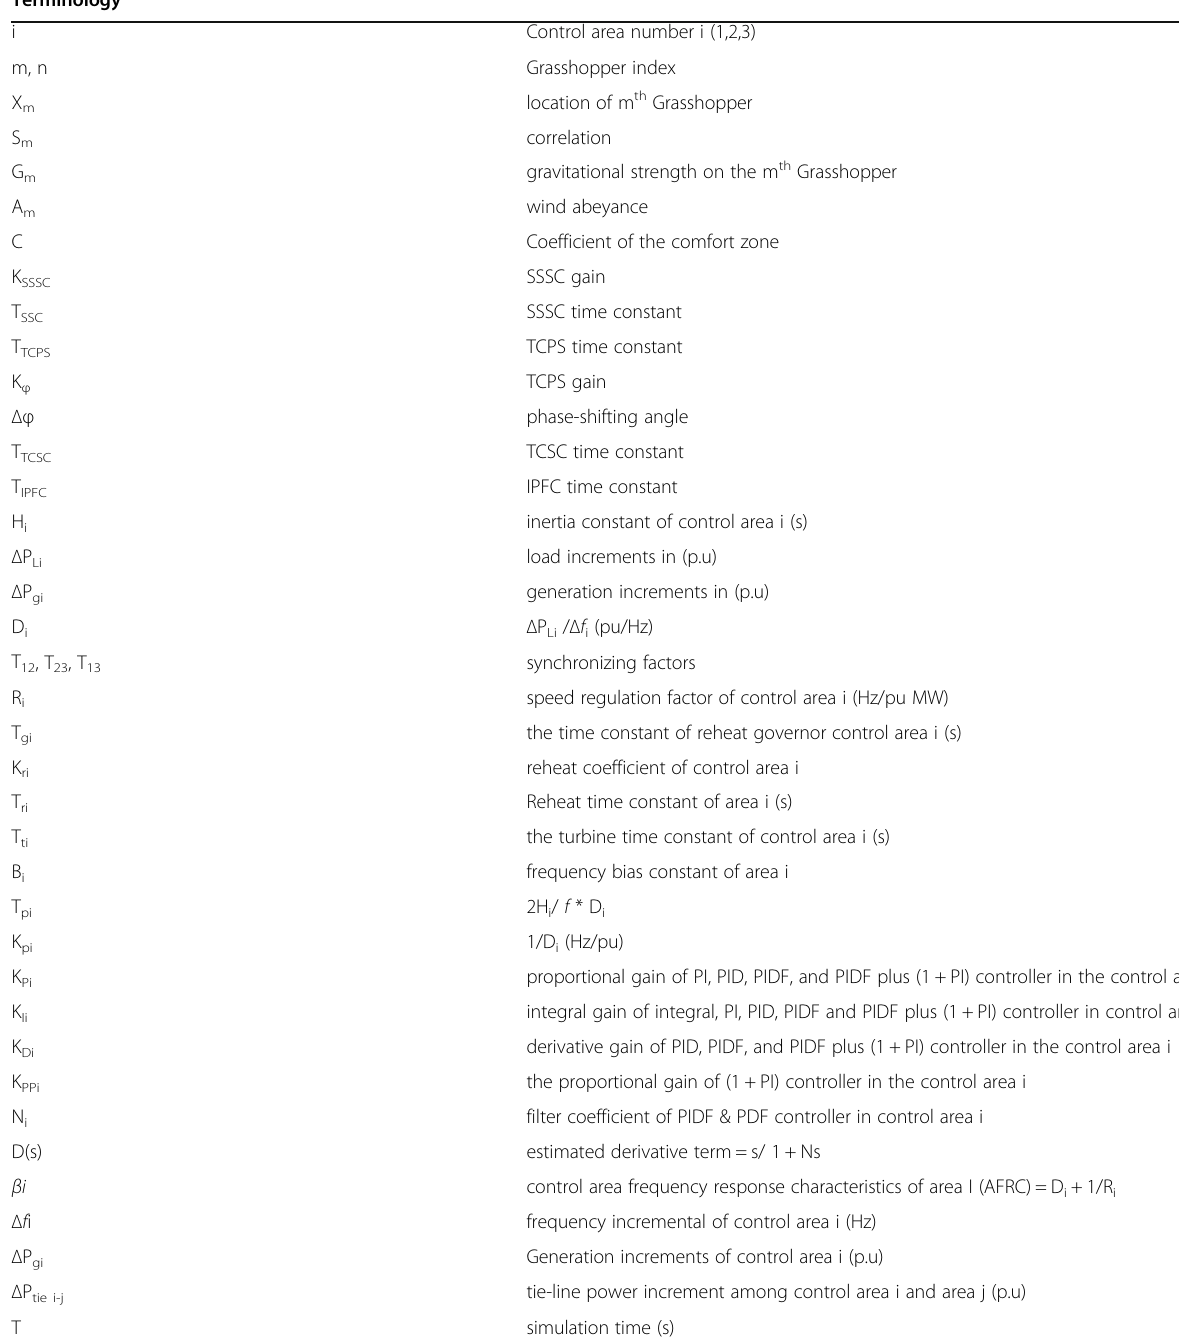
Table 7 Nominal parameters of the system: system frequency f = 60 Hz, Tgi = 0.08 s, Tti = 0.3 s; Tri = 10 s; Kri = 0.5; Kpi = 120 Hz/pu MW; Tpi = 20 s; T12 = 0.086 pu MW/rad; Hi = s; Di = 8.33X10 – 3 pu MW/Hz; β i = 0.425 pu MW/Hz; Ri = 2.4 pu Hz/MW; loading =